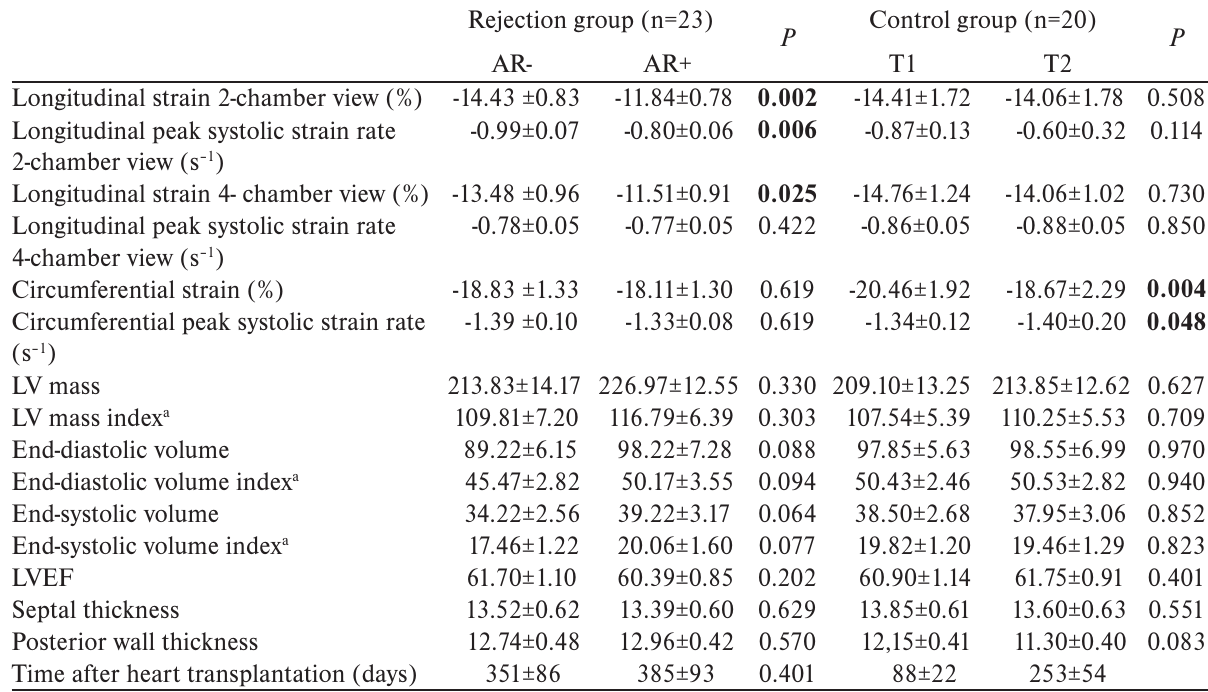
Table 2. Global strain and strain rate values and echocardiography characteristics of both the Rejection group and the Control